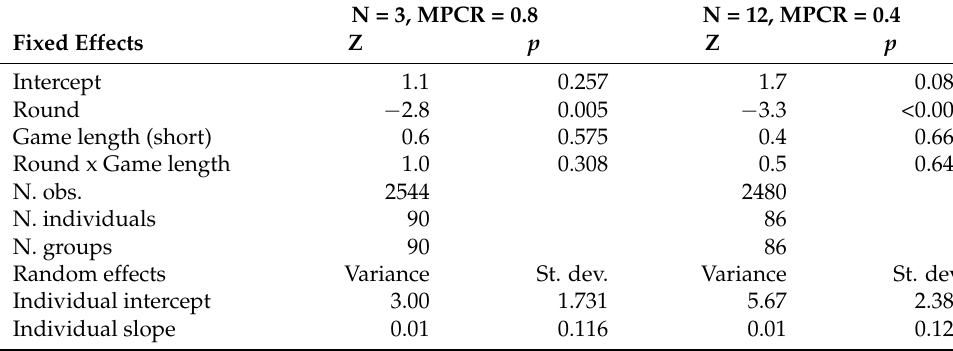
Table 4. The effect of game length. Analysis of how inputs change during the game for each black box depending on game length (16 or 40 rounds). Generalised linear mixed model with a binomial logit link and random intercepts and slopes for